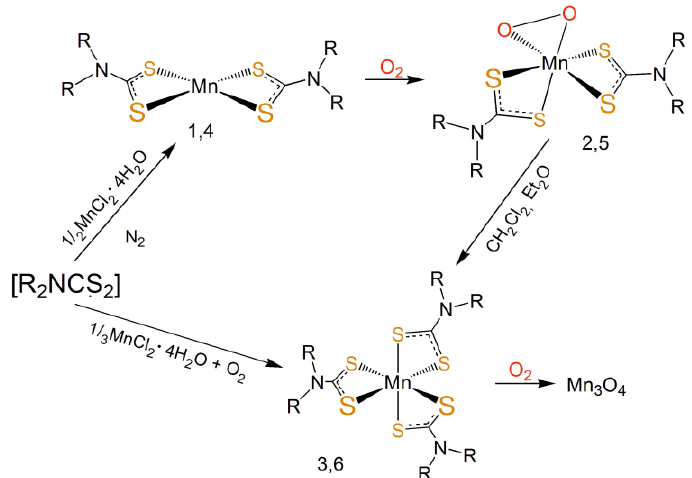
Figure 4. Proposed reaction schemes of Mn(II) and the ligands L and L’ in dioxygen-free atmo- spheric conditions and in open atmosphere. Compounds 1 , 2 , 3 : R = -CH 2 CH 3 (L); compounds 4 , 5 , 6 : R = -CH 2 CH 2 OCH 2 CH 3